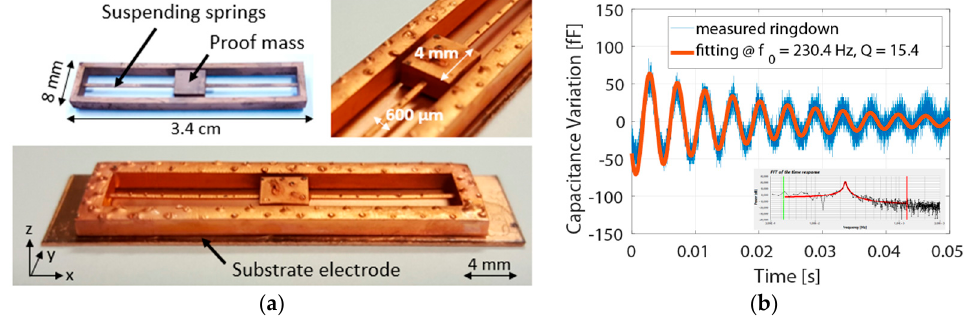
Figure 1. ( a ) Pictures of the 3D printed and electroless Cu metallized accelerometer; ( b ) ring-down measurements during a downward step to the rest